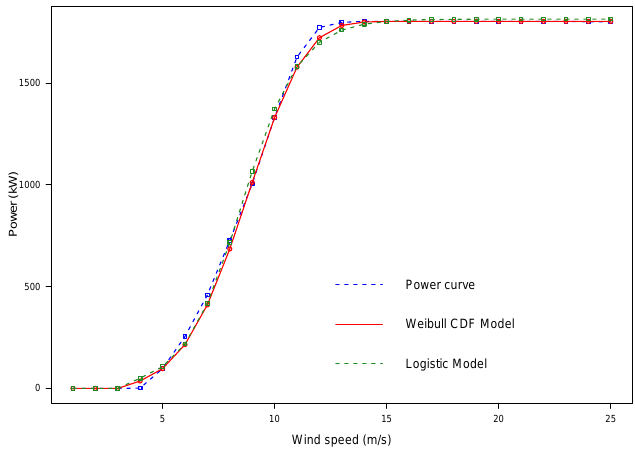
Figure 2. Weibull CDF and 4P-OP models for the Vestas V80 2-MW power curve.